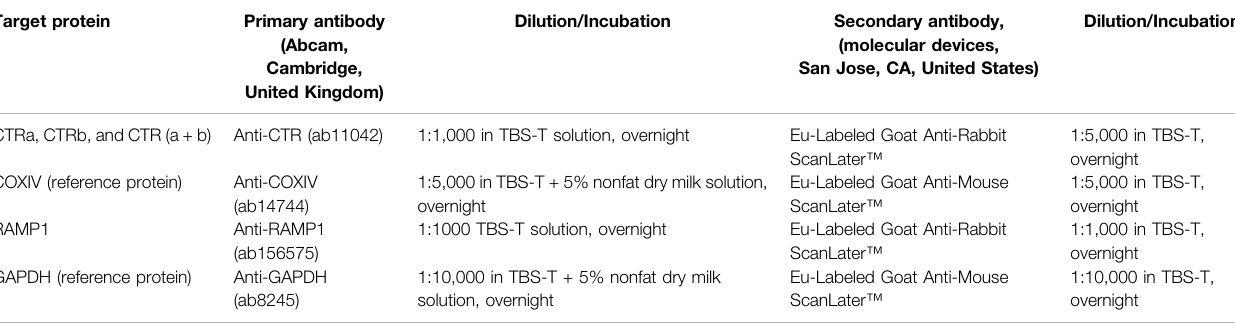
TABLE 1 | Antibodies and dilutions used in the Western Blot experiments. Target